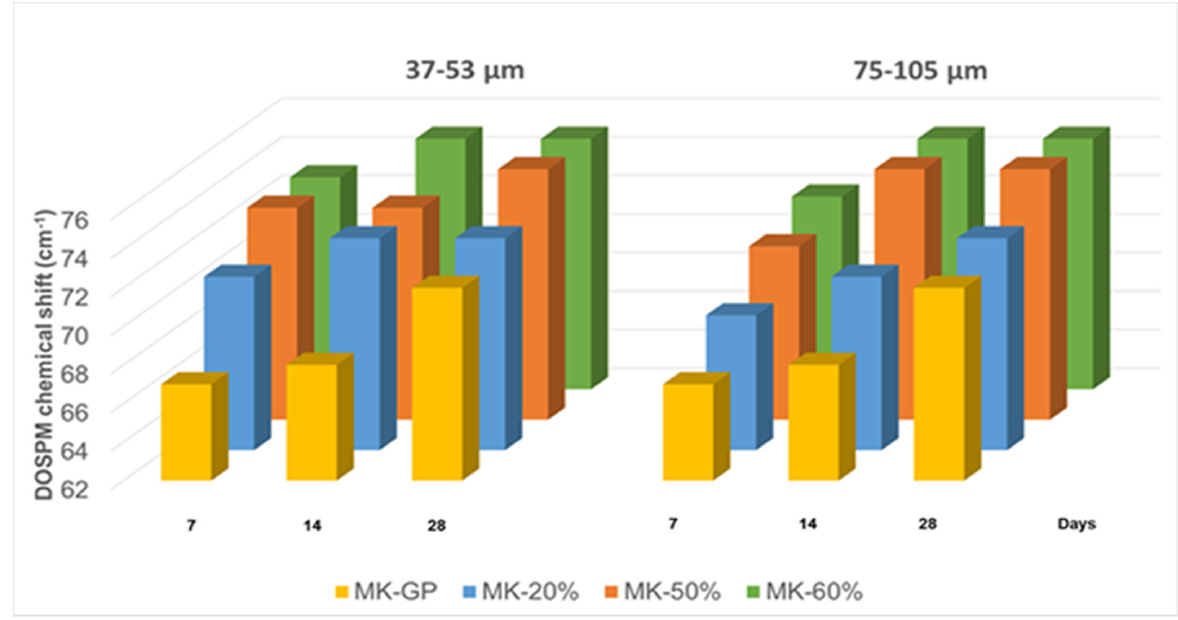
Figure 9. DOSPM chemical shift from MK of all the samples as function of curing time and WG size. FT-IR spectra (1400–750 cm − 1 ) of MK and GP/WG (20, 50 and 60%), both grain sizes